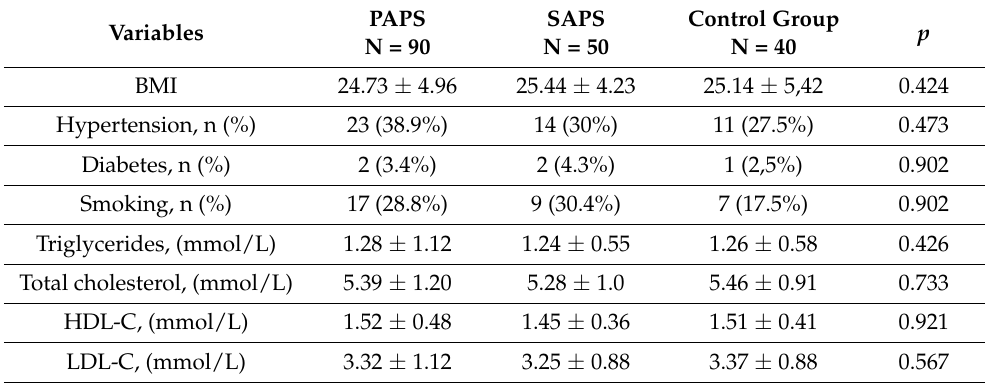
PAPS SAPS Control Group N = 90 N = 50 N = 40